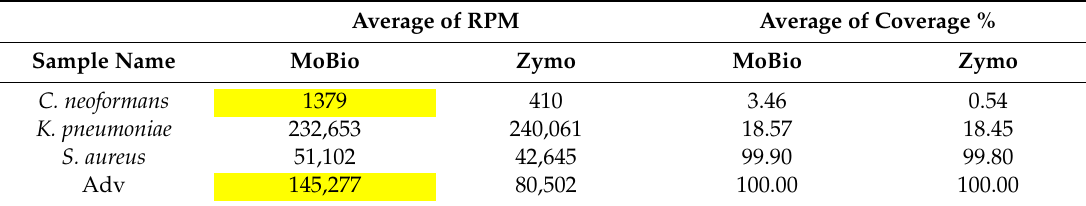
The highlighted cells contain significant